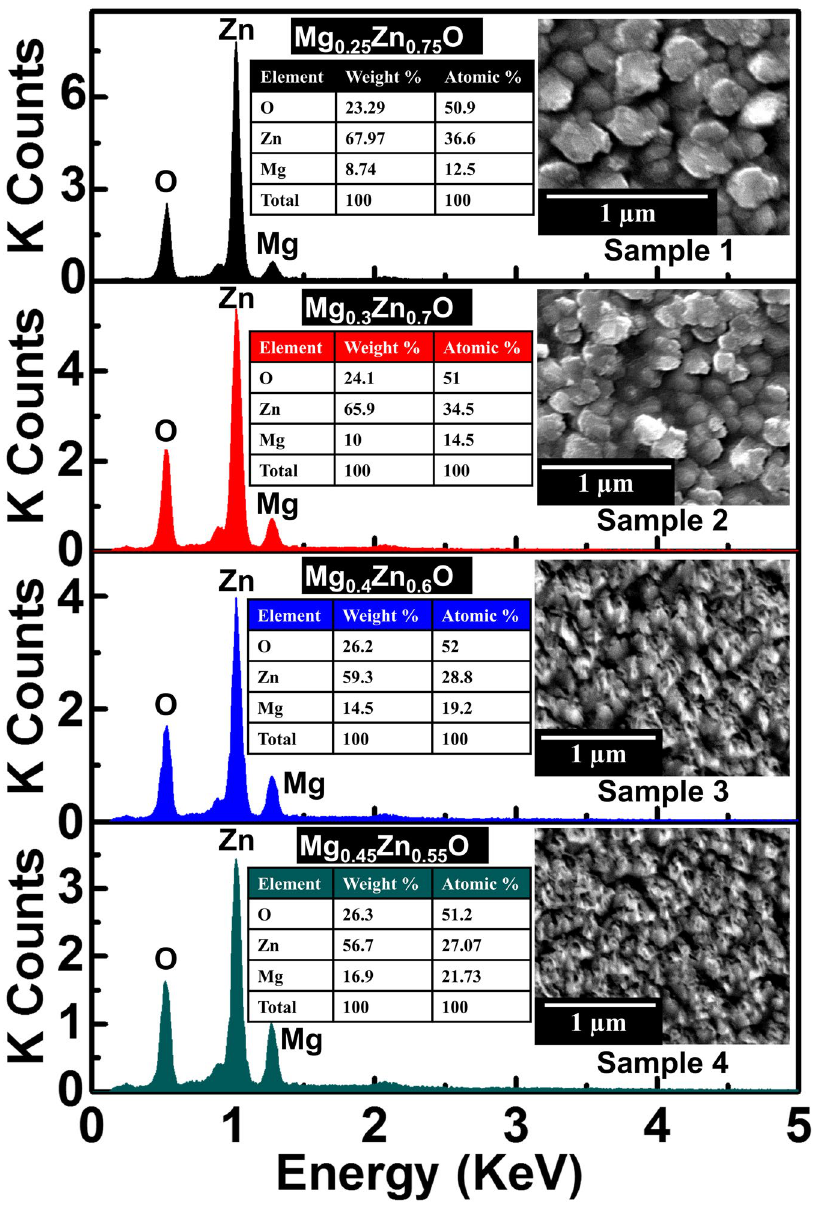
Figure 1. Composition and morphology of MgZnO thin films. EDX spectra of ( a ) Sample 1 (Mg 0.25 Zn 0.75 O), ( b ) Sample 2 (Mg 0.3 Zn 0.7 O), ( c ) Sample 3 (Mg 0.4 Zn 0.6 O), and ( d ) Sample 4 (Mg 0.45 Zn 0.55 O). Inset shows SEM images and tables summarizing the elemental compositions of the